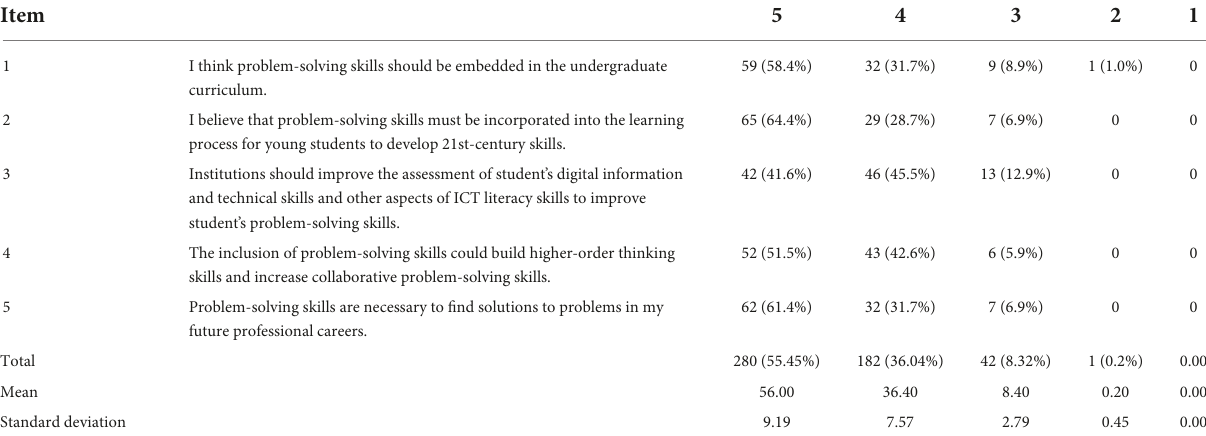
TABLE 2 Problem-solving